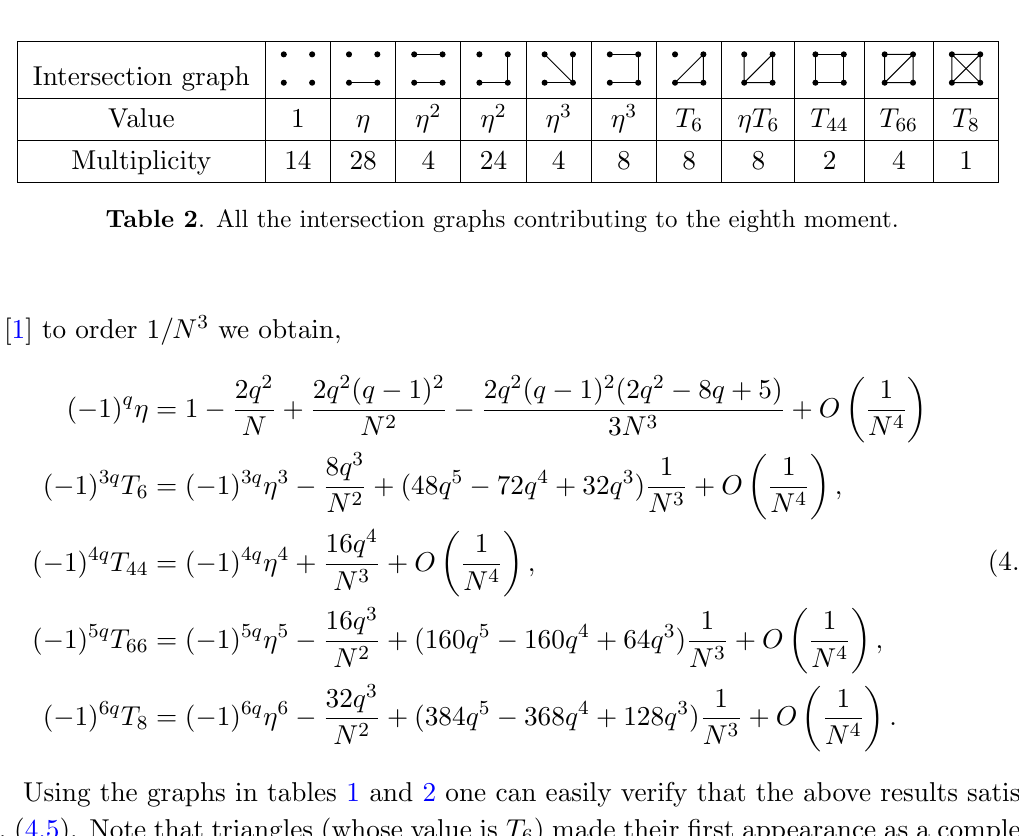
Table 1 . All the intersection graphs contributing to the sixth moment.